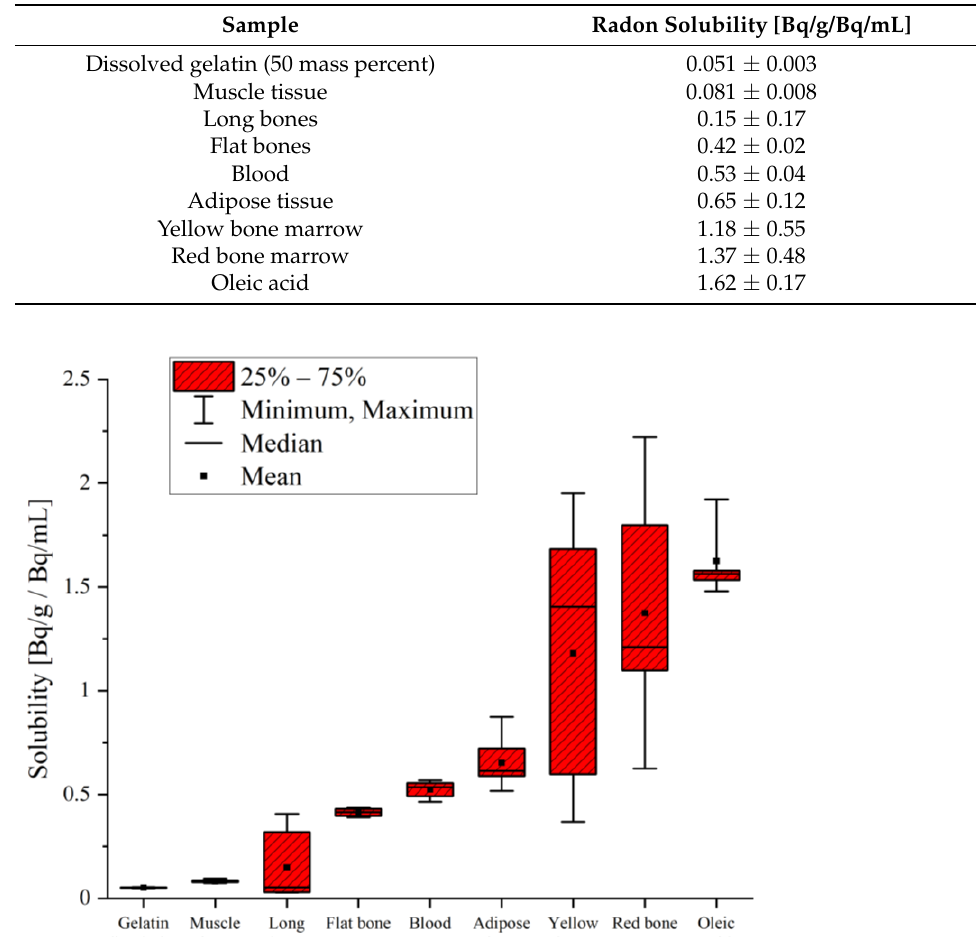
Table 3. Radon solubility in different samples.